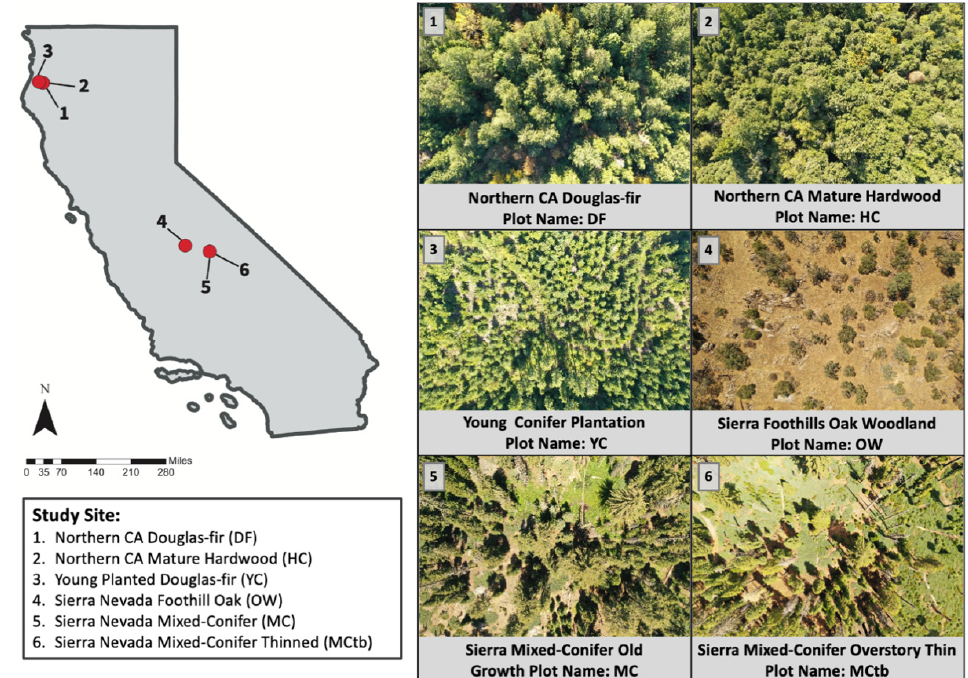
Figure 2. Study site locations across California USA with associated UAS DAP images for each site. The UAS imagery was acquired at 120 m above ground level.